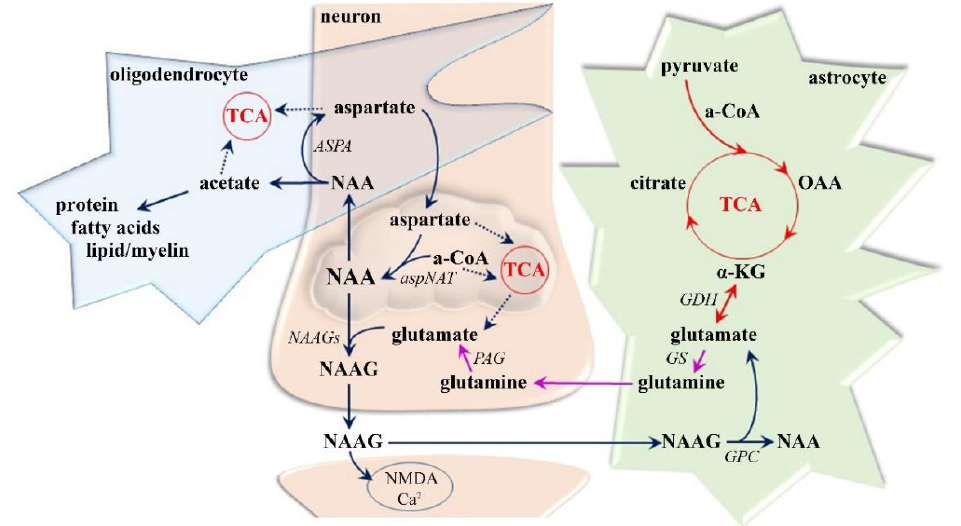
Figure 2. Schematic representation of N-acetyl-aspartate (NAA) metabolism. Acetyl coenzyme A (a-CoA) derived from pyruvate in neuronal mitochondria can be oxidized for adenosine triphosphate (ATP) production in the tricarboxylic acid (TCA) cycle or can be converted to citrate via citrate synthase or to NAA via aspartate N-acetyltransferase (aspNAT) in neuronal mitochondria. On the one hand, NAA is predominantly transported to oligodendrocytes for degradation via aspartoacylase (ASPA) and further use in protein, fatty acid/myelin lipid synthesis, and energy production. On the other hand, neuronal NAA can also combine with glutamate to produce N-acetylaspartylglutamate (NAAG) via NAAG synthetase (NAAGs). The latter is co-released from synaptic vesicles together with several neurotransmitters and can act on the glutamate receptor (N-methyl-D-aspartate (NMDA); presynaptic type 3 metabotropic glutamate receptors) where, via blocking, Ca 2+ channels inhibit glutamate function. NAAG can also be hydrolyzed at the surface of astrocytes to NAA and glutamate via carboxypeptidase (GPC). In astrocytes, glutamate can, via glutamate dehydrogenase (GDH), be converted to α -ketoglutarate ( α -KG) as part of the TCA cycle. Glutamate can also be combined with ammonia to produce glutamine via glutamine synthase (GS). Neurons can take up glutamine and use it as a source of glutamate via phosphate-activated glutaminase (PAG). Thus, NAA and glutamate can produce their own general circulation.